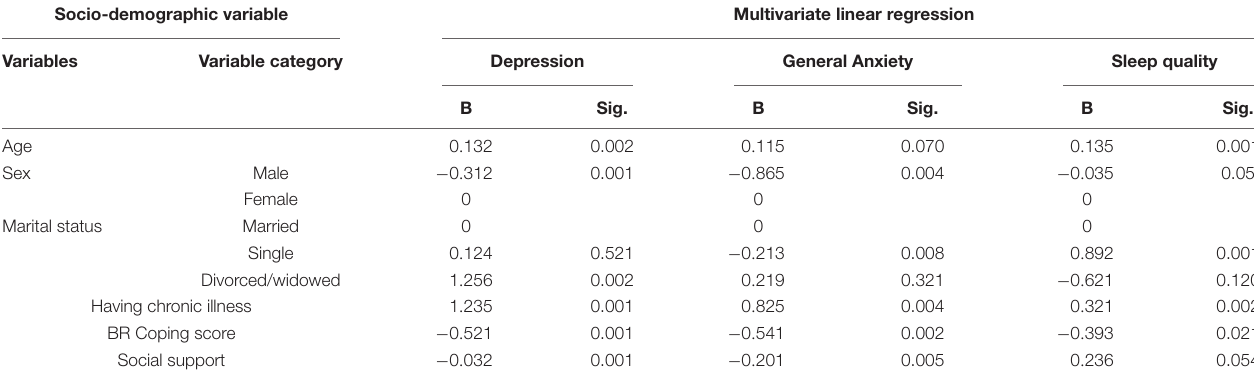
TABLE 3 | Multivariate analyses of factors related to depression, anxiety, and insomnia. Socio-demographic variable Multivariate linear